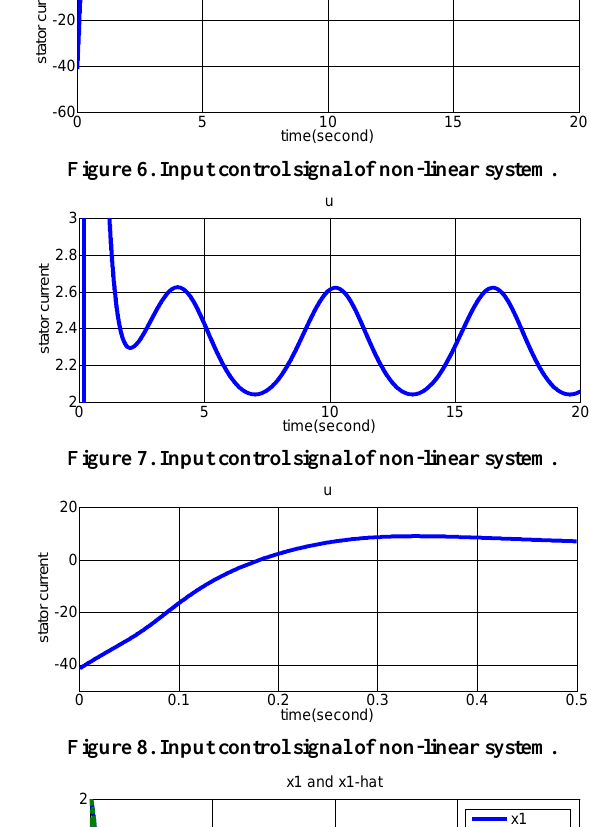
Figure 8. Input control signal of non-linear system.